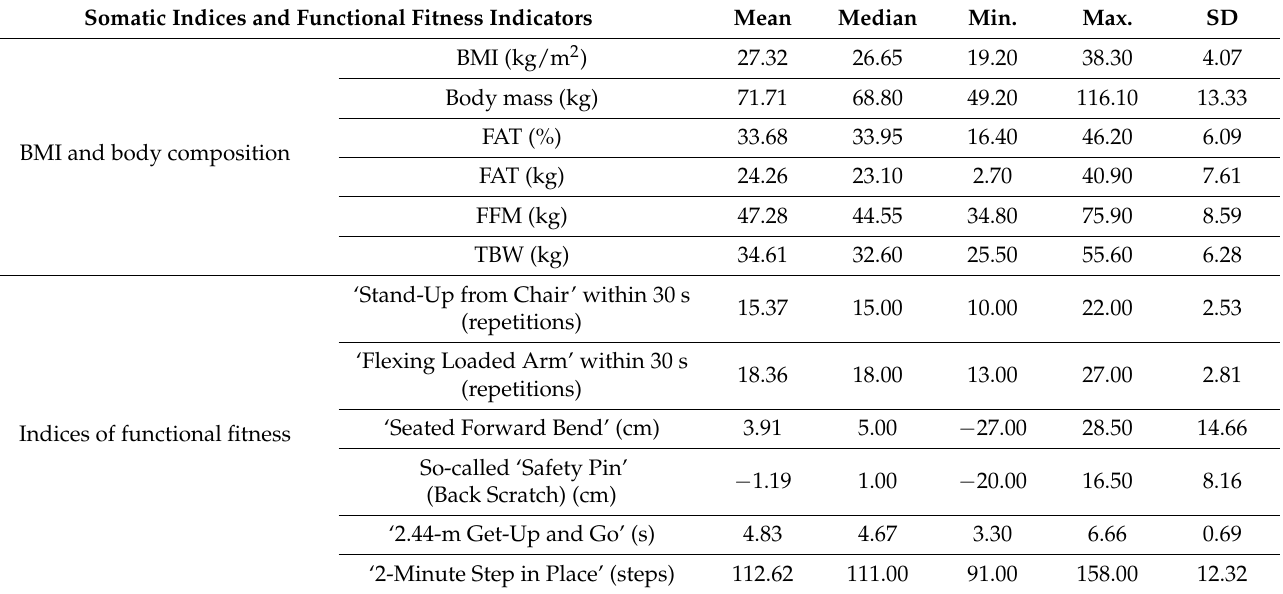
Table 2. Level of body composition indices (BIA) and functional fitness indicators (Fullerton test) among women participating in the “Healthy Active Senior” programme (N = 120) (descriptive